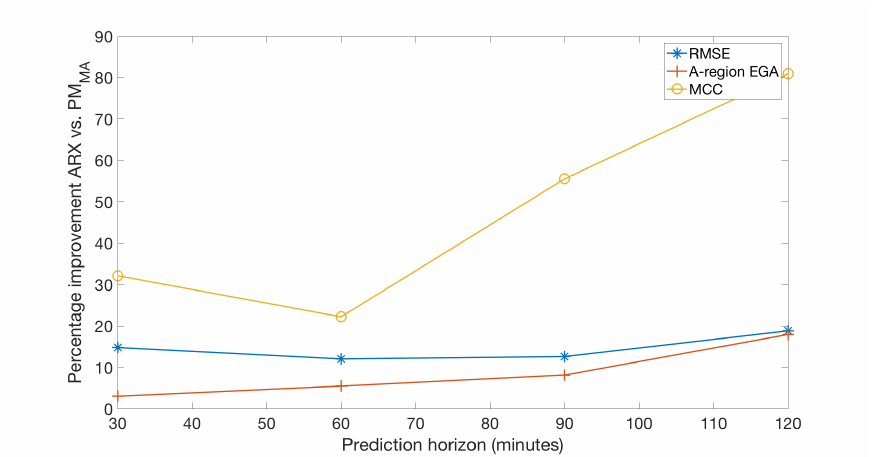
Figure 3. Average percentage of improvement against prediction horizon for three of the evaluated metrics (RMSE, A-region of EGA, and MCC) when comparing the proposed method PM MA versus the ARX model on the 10-adult real cohort.